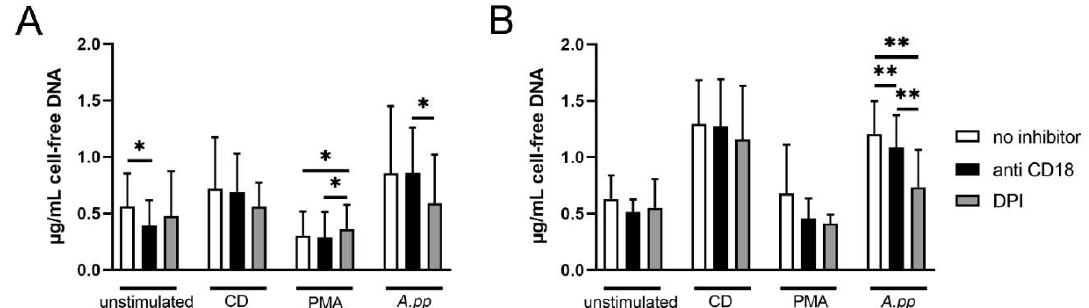
Figure A3. Detection of cell-free DNA in the NET inhibition assay with A.pp after 1 h incubation ( A ) and after 3 h ( B ). ( A ) After 1 h incubation, neutrophils released in the absence of inhibitors the highest amount of cell-free DNA after A.pp infection. DPI inhibited the release of cell-free DNA after 1 h in A.pp infected neutrophils; ( B ) After a 3 h incubation period A.pp- and CD-stimulated neutrophils released significantly more cell-free DNA. The release of cell-free DNA from A.pp- infected neutrophils was significantly reduced after preincubation with anti-CD18a and DPI. All data were analyzed with one-tailed paired Student’s t -test (* p < 0.05, ** p < 0.01) and are presented with mean ± SD (1h incubation n = 3, 3 h incubation n = 5).